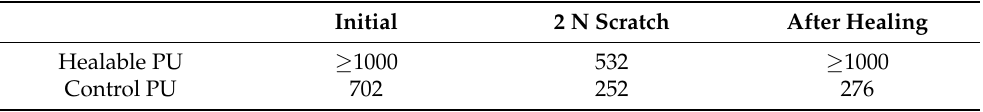
Table 6. Water barrier properties of bio-based 2K PU coated polyester fabric initially, after scratch damage and after